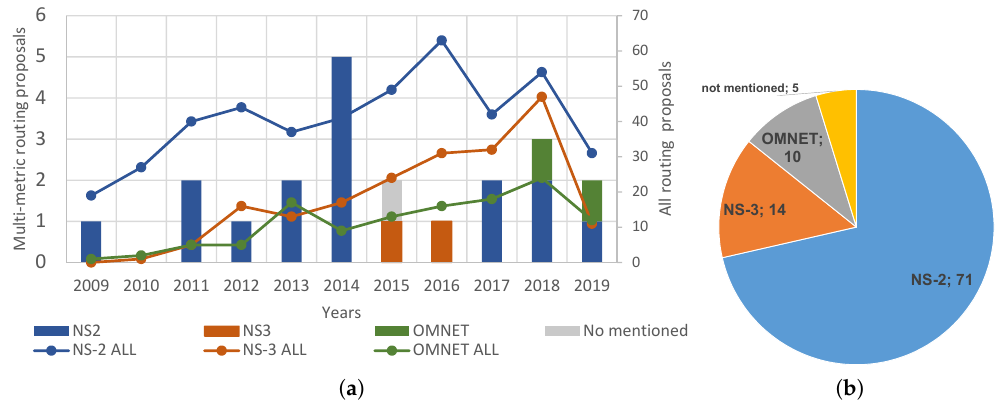
Figure 2. Multimetric routing protocols proposed for VANETs along time. ( a ) Bars account for multimetric routing proposals grouped by network simulator. All routing proposals for VANETs over the years are plotted in lines for different network simulators. ( b ) Distribution of network simulator that used multimetric routing proposals.